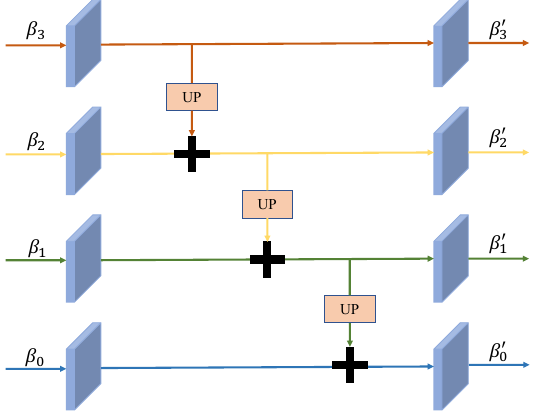
Figure 4. Structure of the feature pyramid model